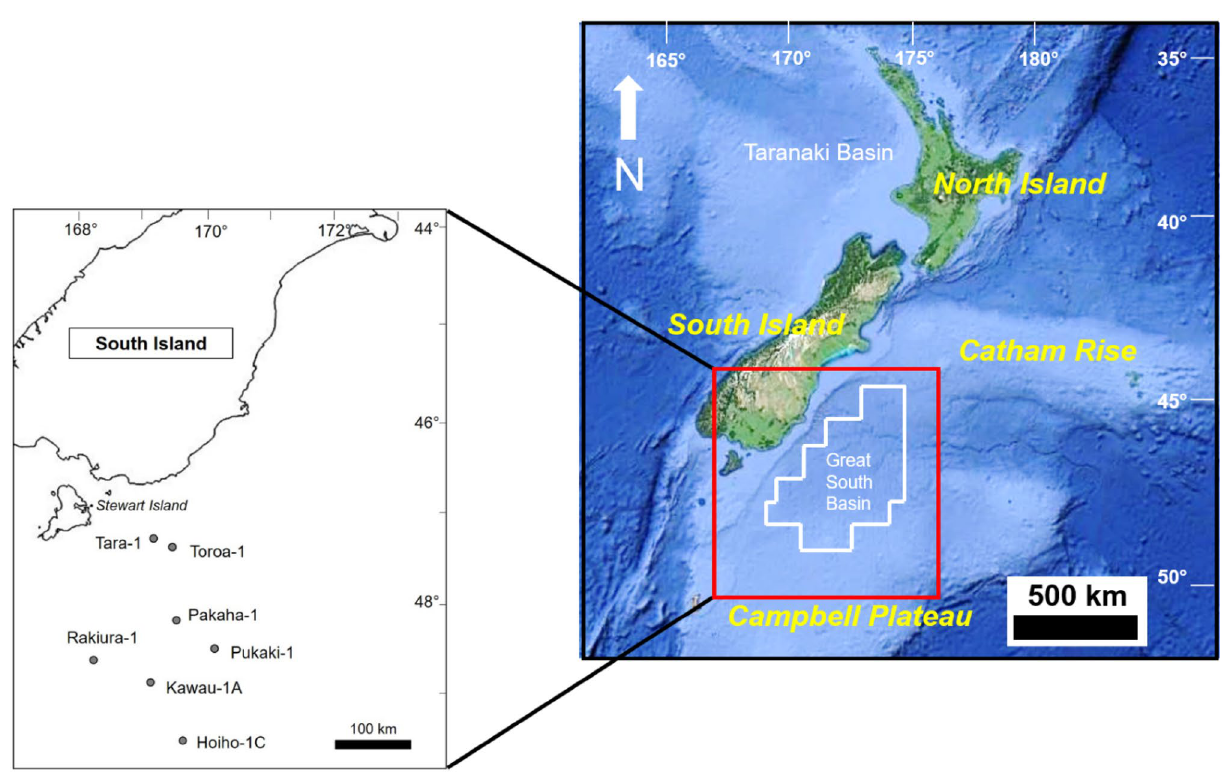
Fig. 1 Map of New Zealand with locations of the Great South Basin and study area. Modified after Schiøler et al.